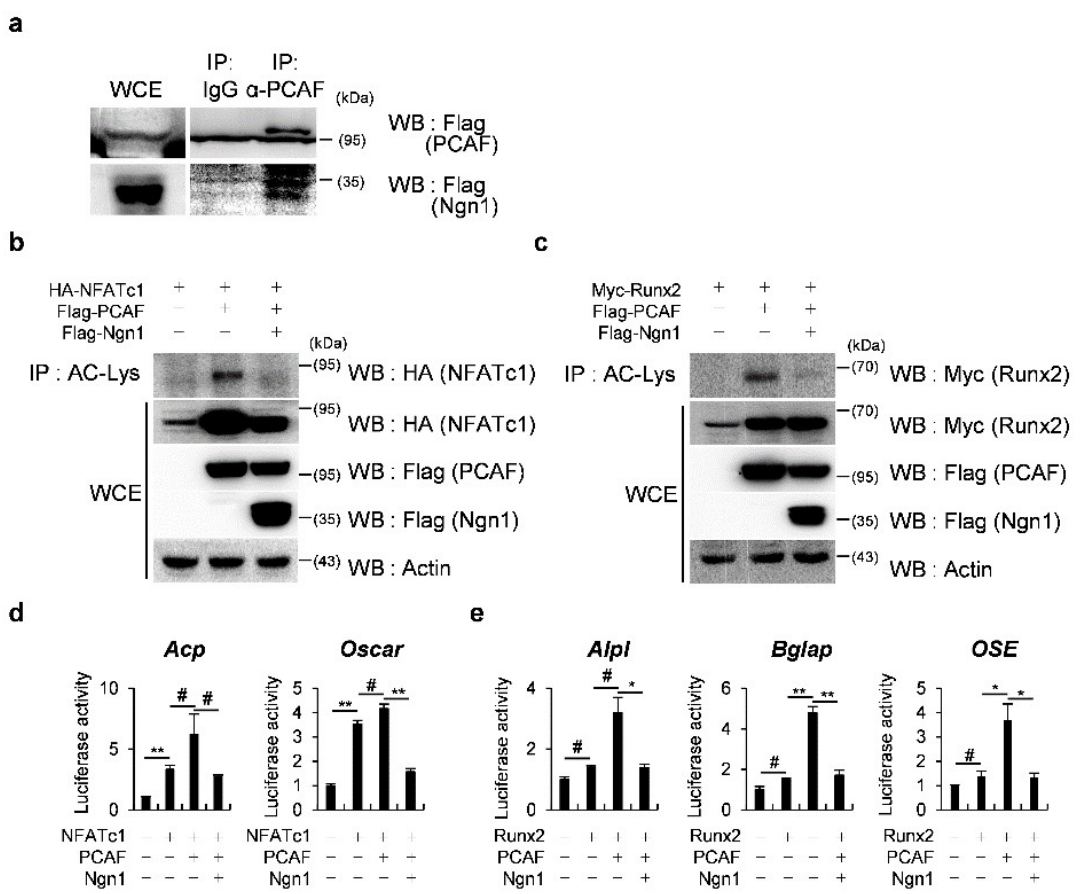
Figure 3. Ngn1 regulated the p300/CREB-binding protein-associated factor (PCAF)-mediated tran- scriptional activities of the nuclear factor of activated T cells 1 (NFATc1) and runt-related transcription factor 2 (Runx2). ( a ) The 293T cells were co-transfected with Flag-PCAF and Flag-Ngn1 and subjected to immunoprecipitation with an IgG or anti-PCAF antibody, followed by Western blot analysis with an anti-Flag antibody. ( b ) The 293T cells were co-transfected with HA-NFATc1, Flag-PCAF, or Flag-Ngn1, as indicated. Cell lysates were subjected to immunoprecipitation with an anti-acetyl-lysine antibody, followed by Western blot analysis of the indicated antibodies. ( c ) The 293T cells were co-transfected with Myc-Runx2, Flag-PCAF, or Flag-Ngn1, as indicated. Cell lysates were subjected to immunoprecipitation with an anti-acetyl-lysine antibody, followed by Western blot analysis with the indicated antibodies. ( d ) The 293T cells were co-transfected with the indicated plasmids along with an Acp5 or Oscar promoter luciferase reporter. Cell lysates were subjected to the luciferase assay. ( e ) The 293T cells were co-transfected with the indicated plasmids along with an Alpl , Bglap , or OSE promoter luciferase reporter. Cell lysates were subjected to the luciferase assay. # p < 0.05, * p < 0.01, ** p < 0.001 vs.